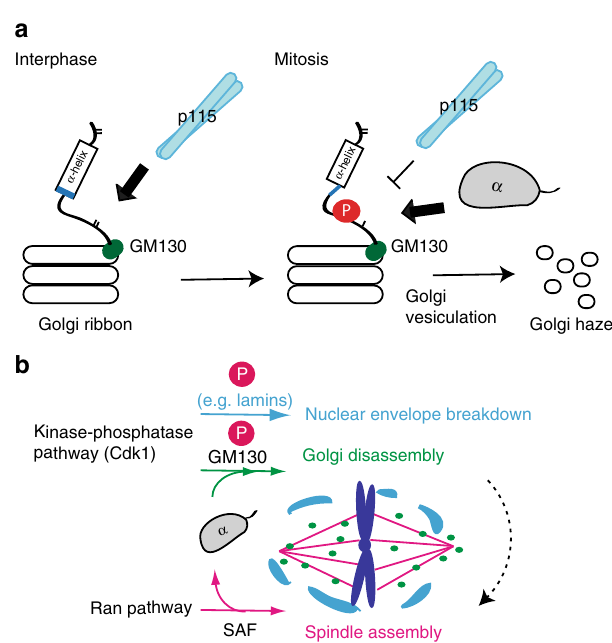
Fig. 8 A schematic model for how Importin- α regulates mitotic Golgi disassembly. a During interphase, p115 facilitates vesicle fusion to the Golgi ribbon by binding to GM130. During mitosis, binding of Importin- α to GM130 is enhanced by mitotic phosphorylation, leading to steric hindrance of the p115 – GM130 interaction and thereby suppressing p115-mediated vesicle fusion, which allows Golgi to undergo vesiculation. b Schematic for how Importin- α coordinates the Ran and kinase-phosphatase pathways to regulate major events of mitosis (NEBD, Golgi disassembly, and spindle assembly). Cdk1 phosphorylates numerous proteins in the nuclear envelope and GM130 in Golgi. Phosphorylation of GM130 enhances binding of the Importin- α that is released from SAFs by Ran, prohibiting p115 binding to GM130, and promoting Golgi disassembly. Golgi disassembly then ensures proper spindle assembly (black dashed line with an arrow). Spindle assembly factor (SAF) is